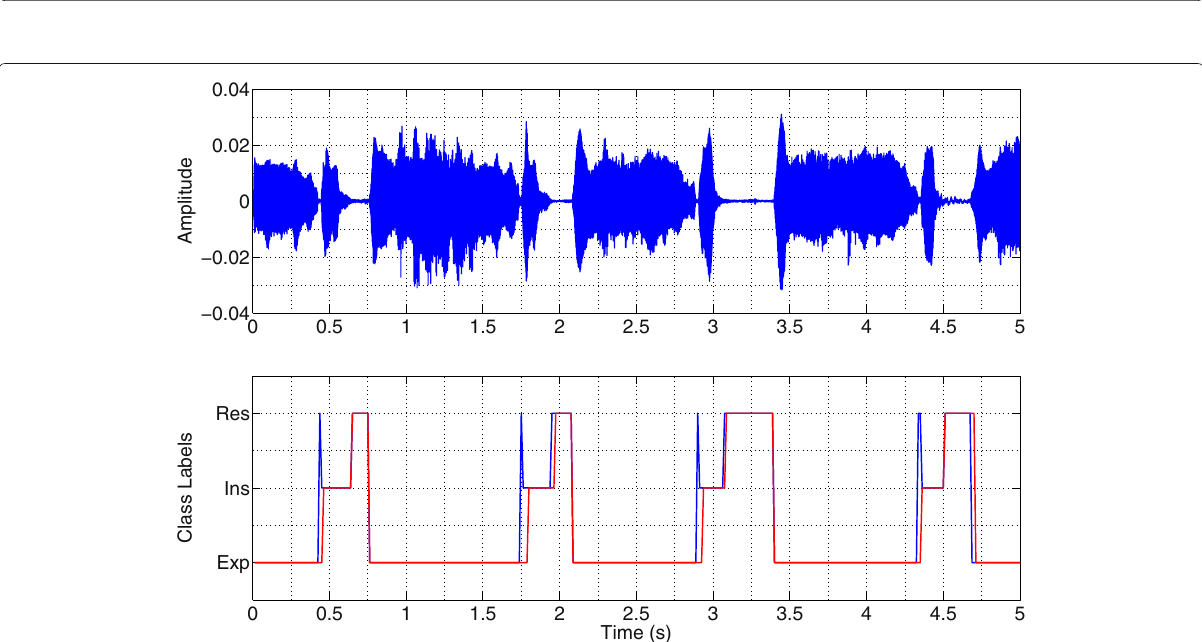
Fig. 5 Audio segmentation results for a chunk of cry signal shown in the top panel. The bottom panel depicts the actual and predicted class labels with blue and red plots,